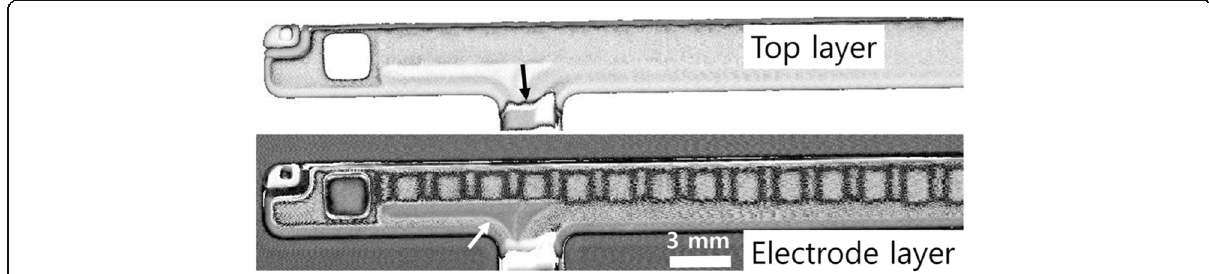
Fig. 5 Image showing the flat panel bonding between a glass and the electrodes, obtained from a C-scan (50 MHz transducer, lateral resolution ~ 30 μ m, 512 px × 128 px)